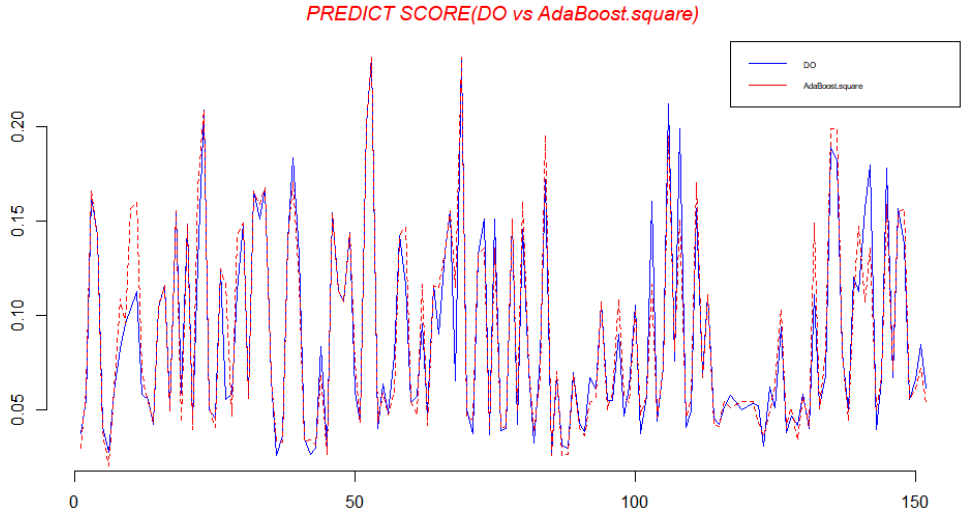
Figure 10. Predicted score (AdaBoost).